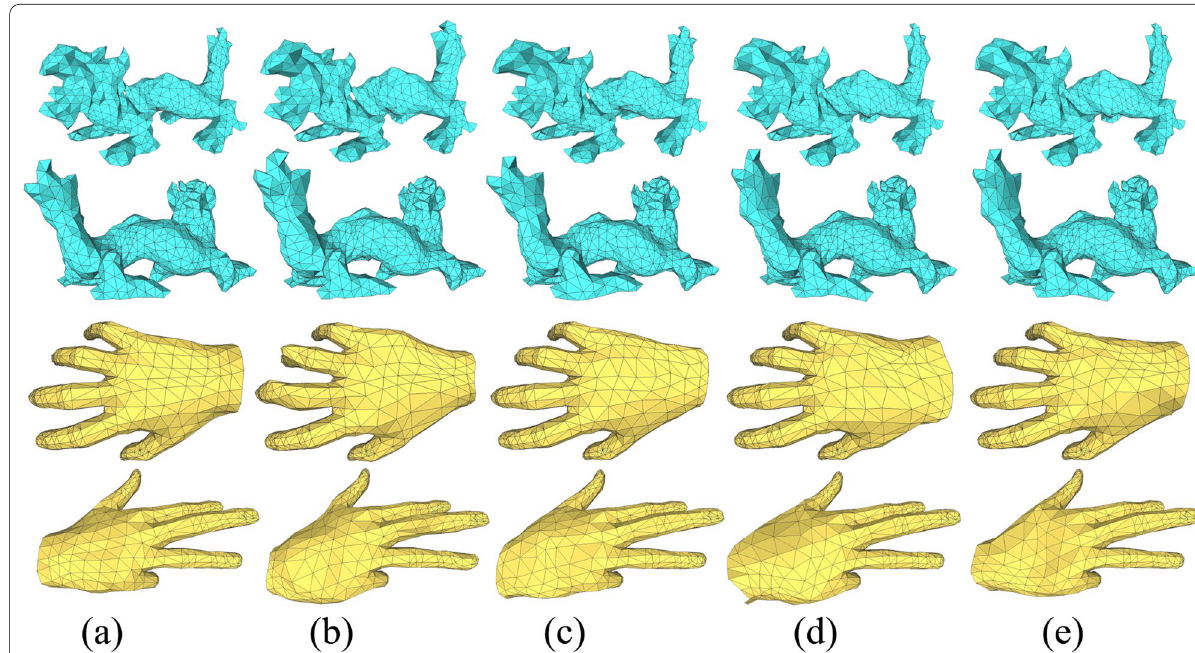
Fig. 9 Visual quality on remeshed Asiadragon (top two rows) and remeshed Hand (bottom two rows) dataset. a Original; b Model; c Model † ; d Pre-Model; e Pre-Model † . † denotes training without the attack layers, Model represents the model trained on the remeshed dataset, and Pre-Model represents the model trained on the original